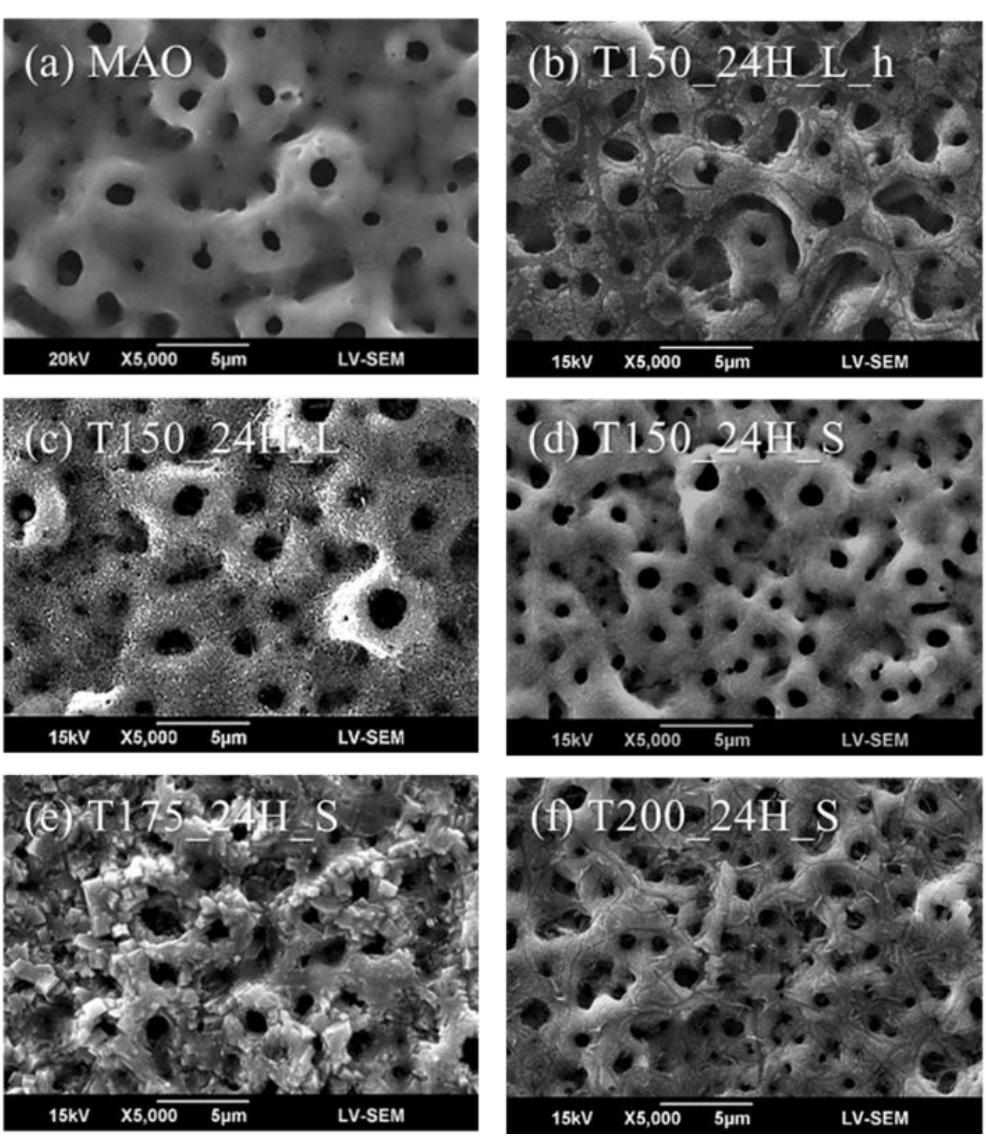
Figure 2. Microstructures of ( a ) the MAO coating and the hierarchical structures fabricated using hydrothermal treatment for 24 h ( b ) at 150 ◦ C in the large reactor and placed in a hanging mesh, ( c ) at 150 ◦ C and immersed in the large reactor, ( d ) at 150 ◦ C and immersed in the small reactor, ( e ) at 175 ◦ C and immersed in the small reactor, and ( f ) at 175 ◦ C and immersed in the small reactor. Table 2. The chemical compositions of the MAO coatings and hierarchical structures fabricated using hydrothermal treatment for 24 h at 150 ◦ C, 175 ◦ C, and 200 ◦